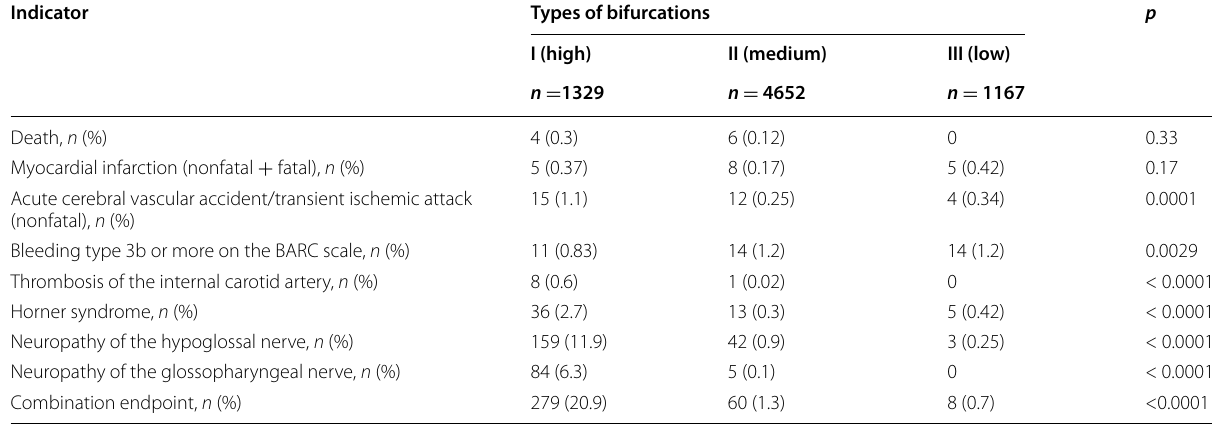
Table 3 Hospital